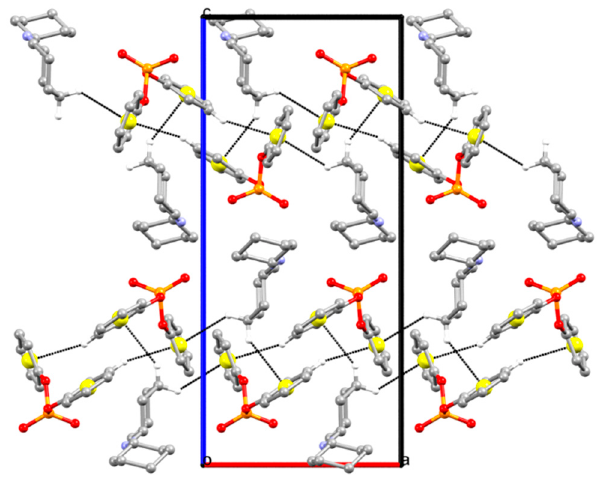
Figure 4. The C–H . . . π interactions of [(C 6 H 11 ) 2 NH 2 ][(C 6 H 5 O) 2 P(O)(O)] viewed along the b direction. Only the hydrogen atoms participating in C–H . . . π interactions are shown, and the C–H . . . π interactions are represented by dashed lines. Color keys are red O, orange P, blue N, gray C, and yellow for centroid of the phenyl ring.